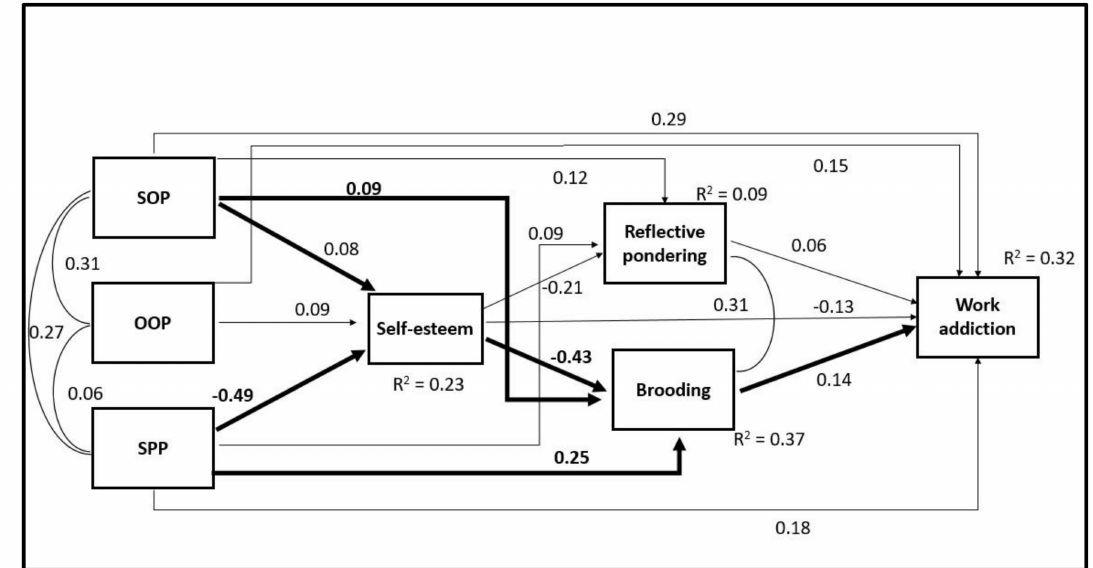
Figure 2. The final model with standardized path coe ffi cients. Notes: All estimations were significant at the p < 0.001 level. The arrows representing the study’s hypotheses are emboldened. SOP = self-oriented perfectionism, OOP = other-oriented perfectionism, and SPP = socially prescribed